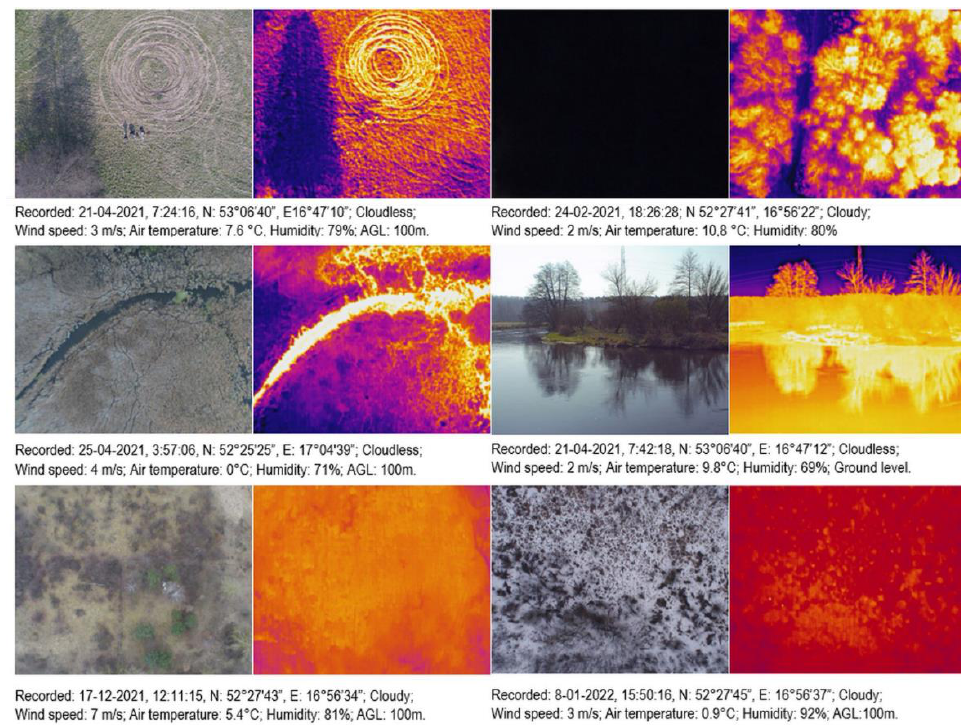
Figure 1. Examples of various pairs of RGB and thermal images taken with the E10T camera. Below the images some information is given about the geographic and meteorological parameters (obtained from the closest station).